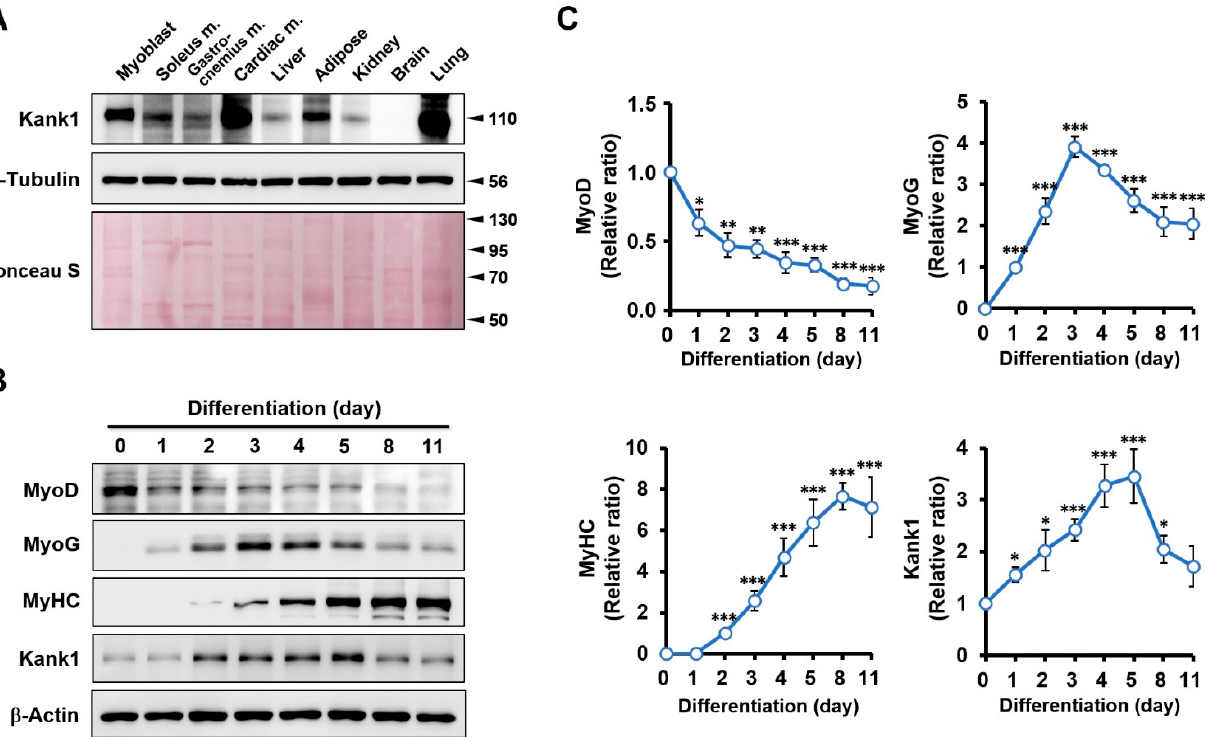
Figure 1. Expression profiles of Kank1 in murine tissues and myogenic differentiation. ( A ) Equal amounts (20 µ g/lane) of protein were prepared from C2C12 myoblasts and adult male mouse tissues and subjected to SDS-PAGE (10%) and immunoblot analysis for Kank1. α -Tubulin was used as the loading control. Representative images are shown. ( B ) C2C12 cells were allowed to differentiate for 11 days. The expression of MyoD, MyoG, MyHC, and Kank1 was determined by immunoblotting. β -Actin was used as the loading control. ( C ) Expression levels in immunoblots were determined by densitometry and normalized versus ß -actin. Values are expressed as the relative ratio, with the intensity of differentiation on day 0 (MyoD and Kank1), day 1 (MyoG), or day 2 (MyHC) set to one. All results are presented as means ± SEMs ( n > 3), and levels of significance are presented as *, p < 0.05; **, p < 0.01; ***, p < 0.001 vs. differentiation day 0.